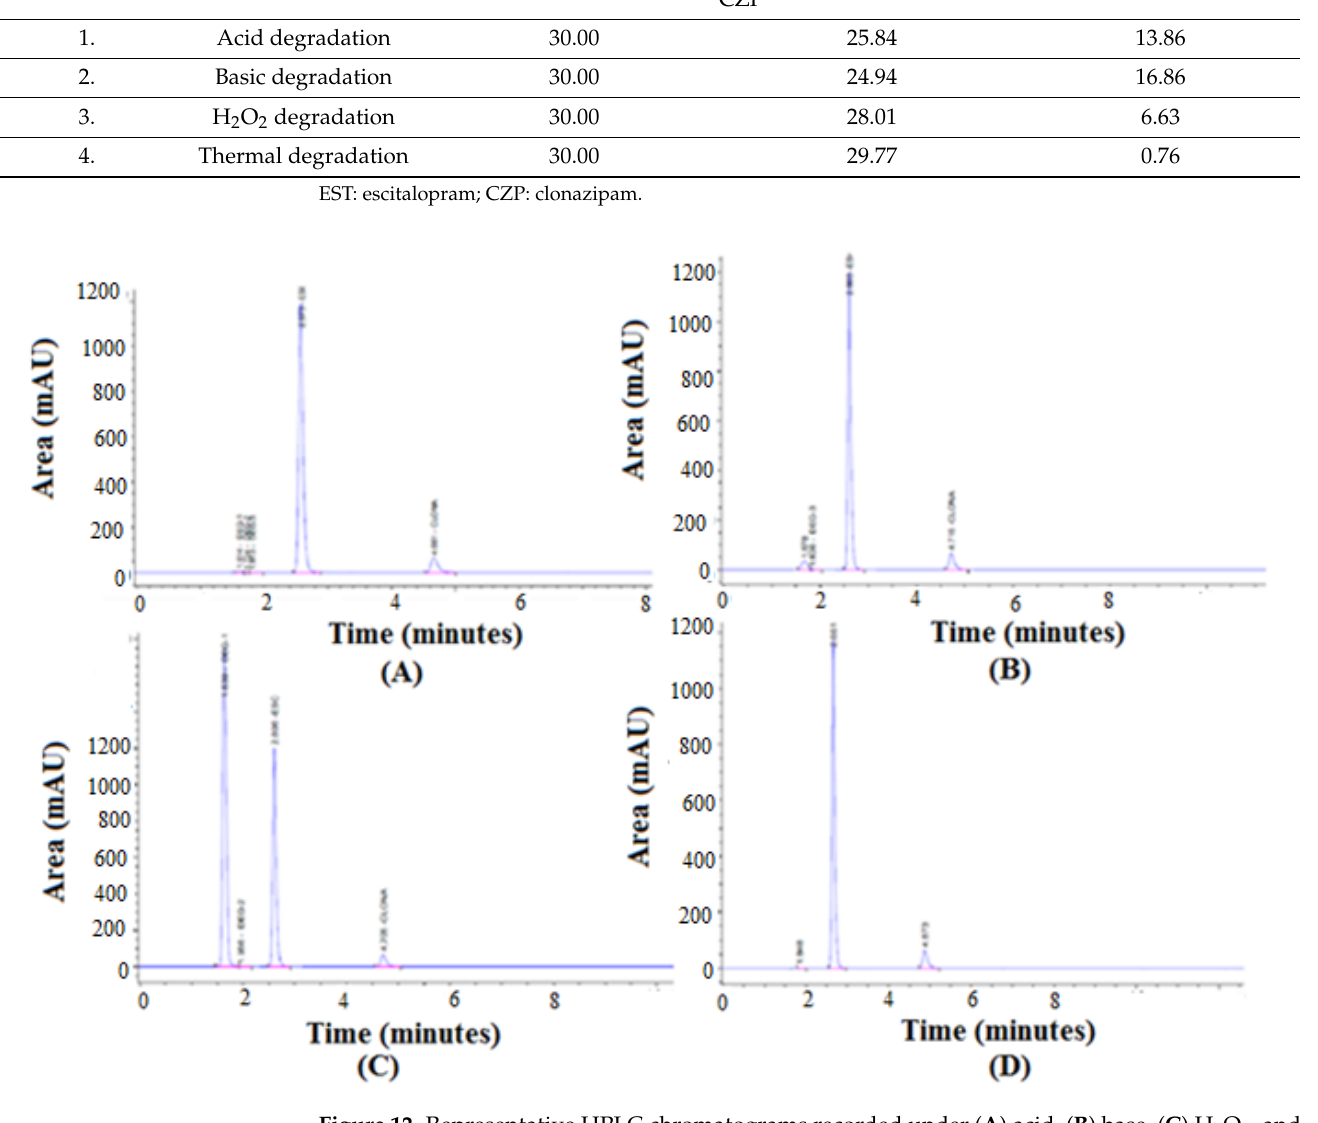
Figure 12. Representative HPLC chromatograms recorded under ( A ) acid, ( B ) base, ( C ) H 2 O 2 , and ( D ) thermal degradation conditions.